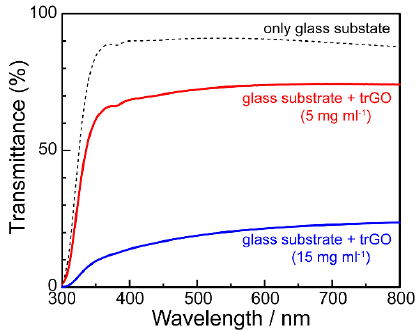
Figure 15. Transmission spectra of trGO films on slide glasses prepared with GO solutions of 5 mg mL − 1 (red) and 15 mg mL − 1 (blue). The dotted line denotes the transmission spectrum of the slide glass itself.